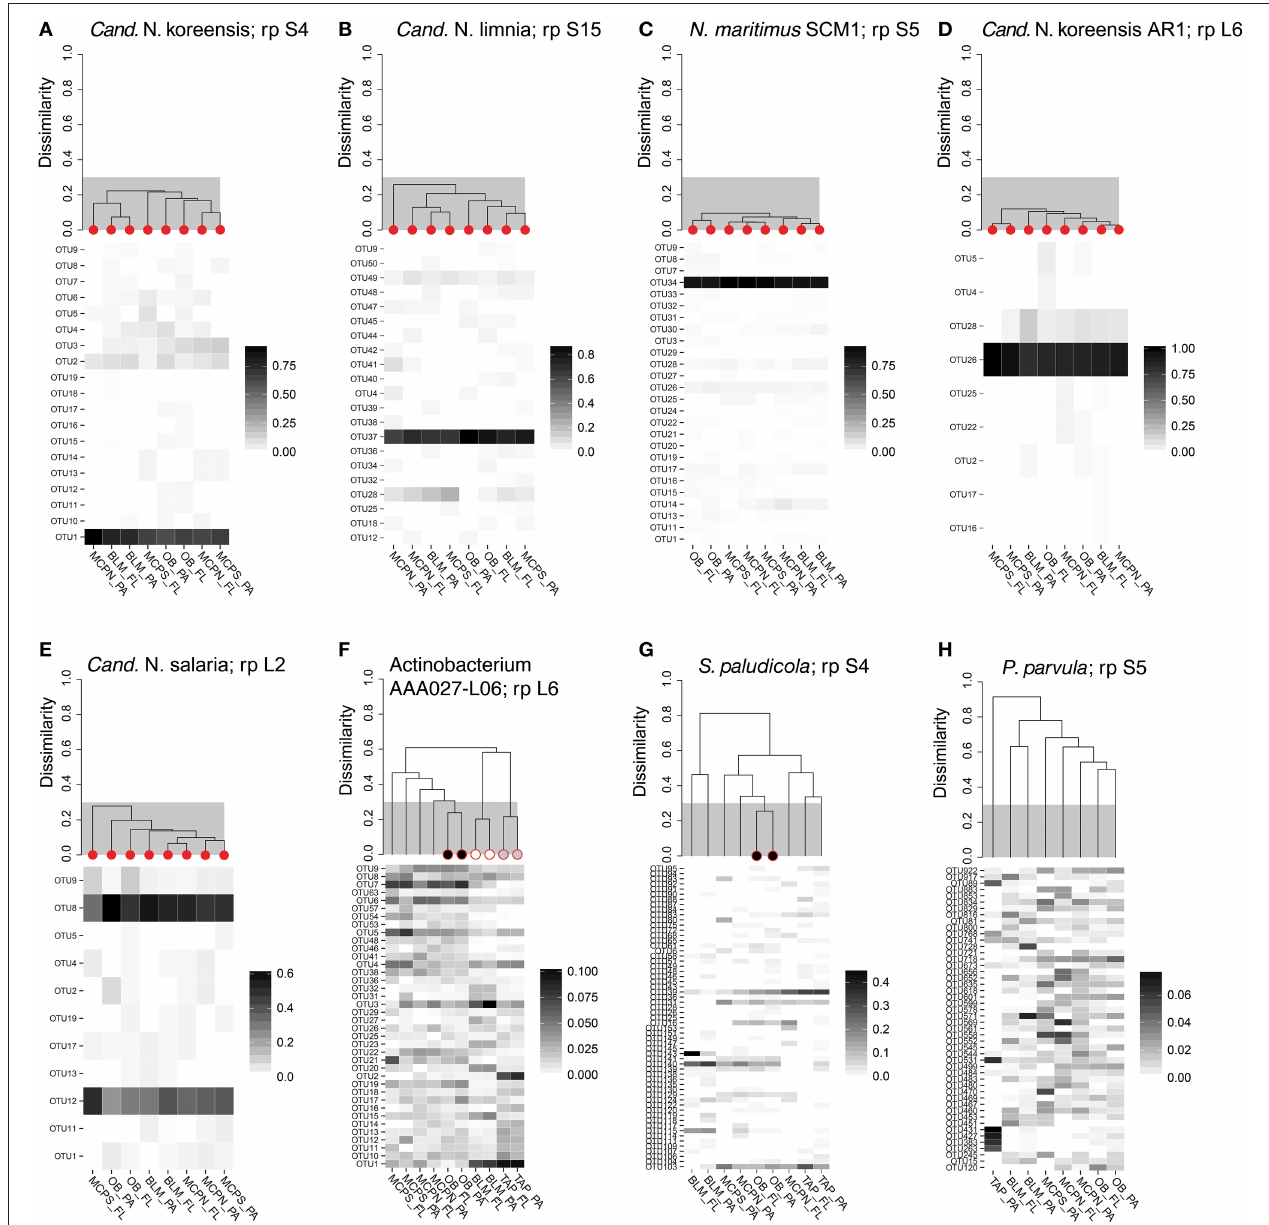
FIGURE 4 | OTU fingerprints and hierarchical clustering of transcripts from a highly-expressed ribosomal protein for eight reference genome bins with high coverage in the metatranscriptomes. Individual samples identified as containing the same population structure at different locations (clustering at < 30% dissimilarity) are marked with red circles in (A–E) . In (F,G) , Actinobacterium AAA027-L06 and Schlesneria paludicola ribosomal proteins met the cut-off criteria for different fractions at the same station, but not across different stations. In (H) , Pedosphaera parvula populations were different for every size fraction and station. The ribosomal protein used in the clustering analysis is indicated after “rp” in the plot